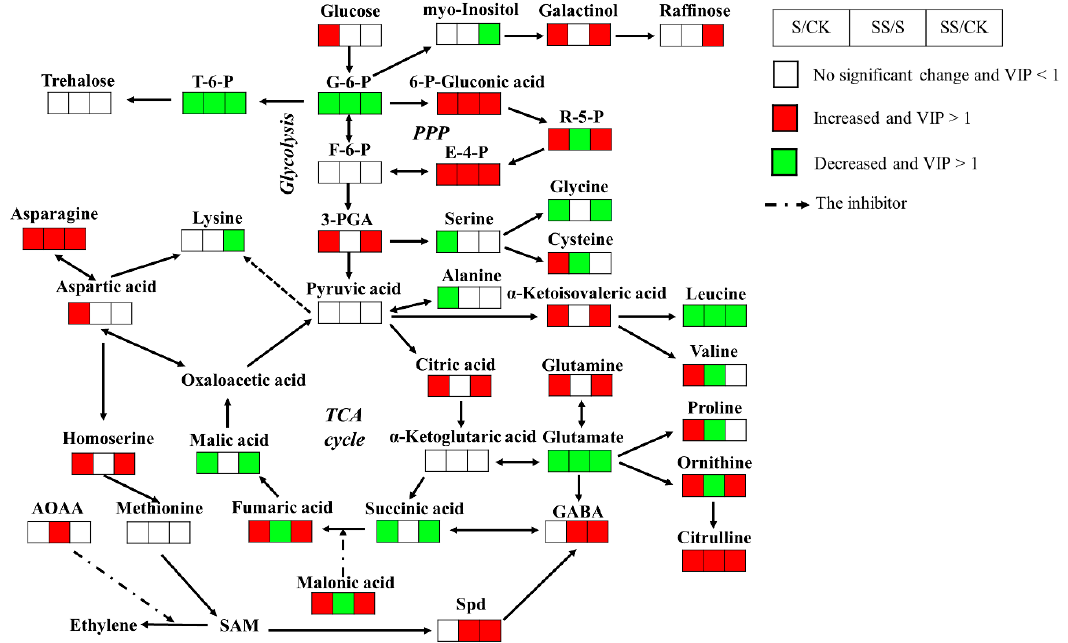
Figure 4. Proposed metabolic network changes in the roots of cucumber seedlings obtained through (orthogonal) partial least-squares-discriminant analysis ((O)PLS-DA) under normal condition and salt stress with or without Spd. CK = control, S = 75 mM NaCl, SS = 75 mM NaCl + 0.1 mM Spd; Significant difference at p < 0.05. Table 1. Root other metabolites responsive to salt stress and Spd (Metabolites not shown in Figure 4).